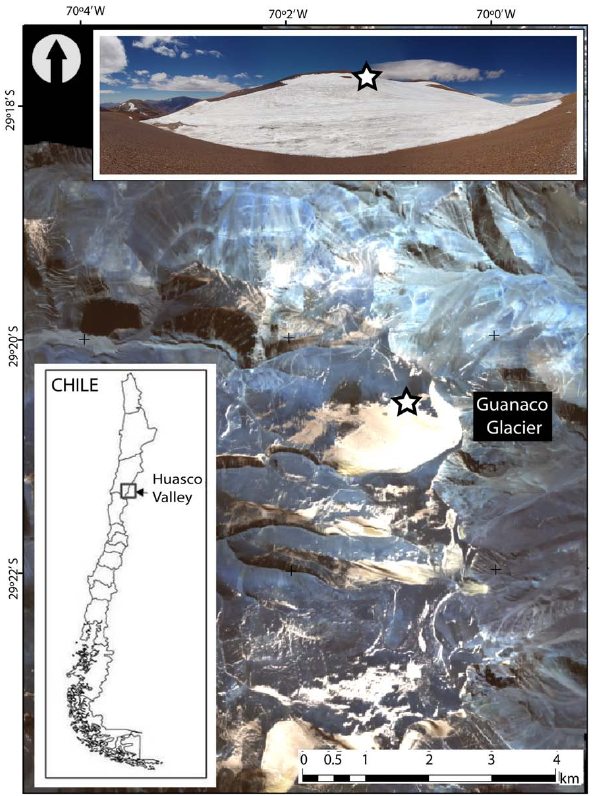
Fig. 1. Ikonos image of the upper Huasco Valley (2005), showing the location of Guanaco Glacier and its automatic weather station (star). The insets show the location of the Huasco Valley in Chile, and an oblique photograph of the Guanaco Glacier taken from its southern-eastern side, looking up the